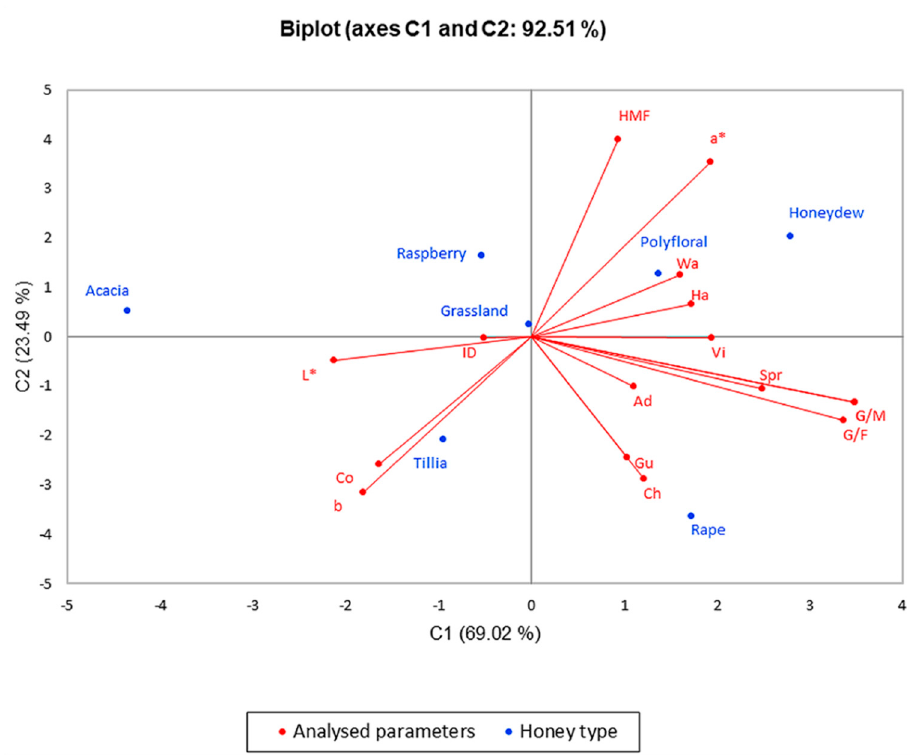
Figure 4. Principal component analysis (PCA) regarding the honey types in the first month of analyses.